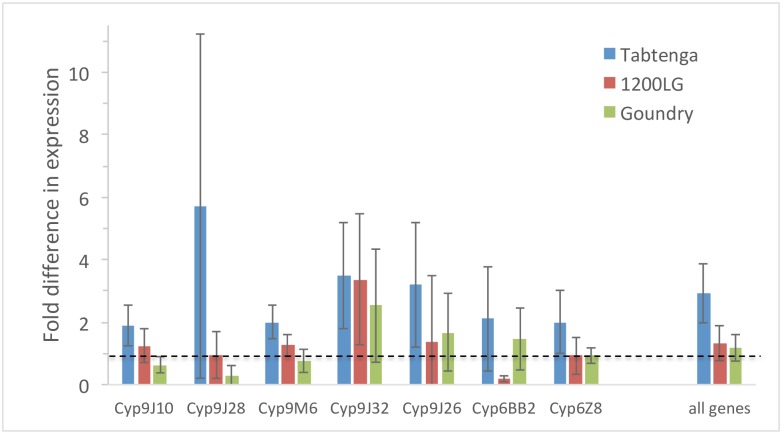
Expression of candidate P450 genes in relation to the susceptible Rockefeller laboratory strain, against which the dashed line indicates parity.Bars show mean fold change ± 95% confidence intervals. The final bars show the average expression across all genes.